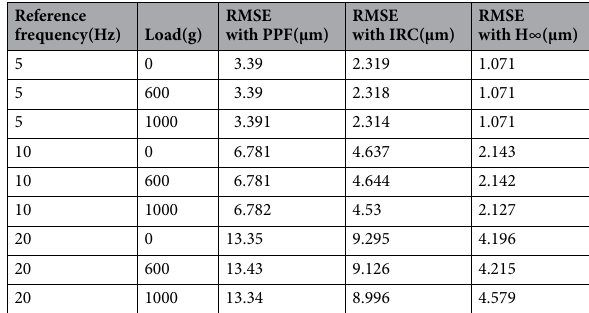
Table 2. System model under different mechanical loads.